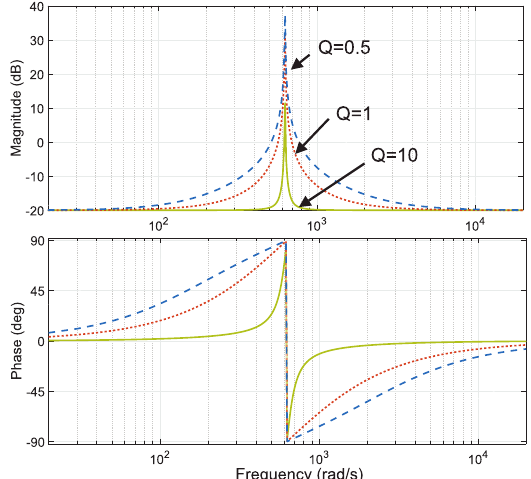
Figure 25. Notch characteristics with different